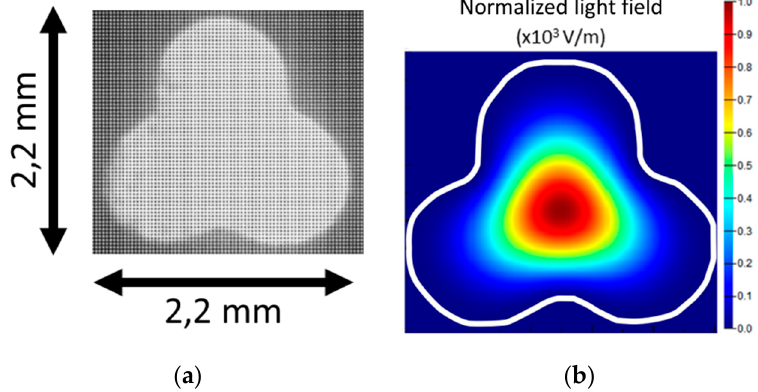
Figure 2. ( a ) Optical microscope image of the cross-section of the three-lobe plastic optical fiber. ( b ) Simulated light field intensity of the fundamental mode at 645 nm.